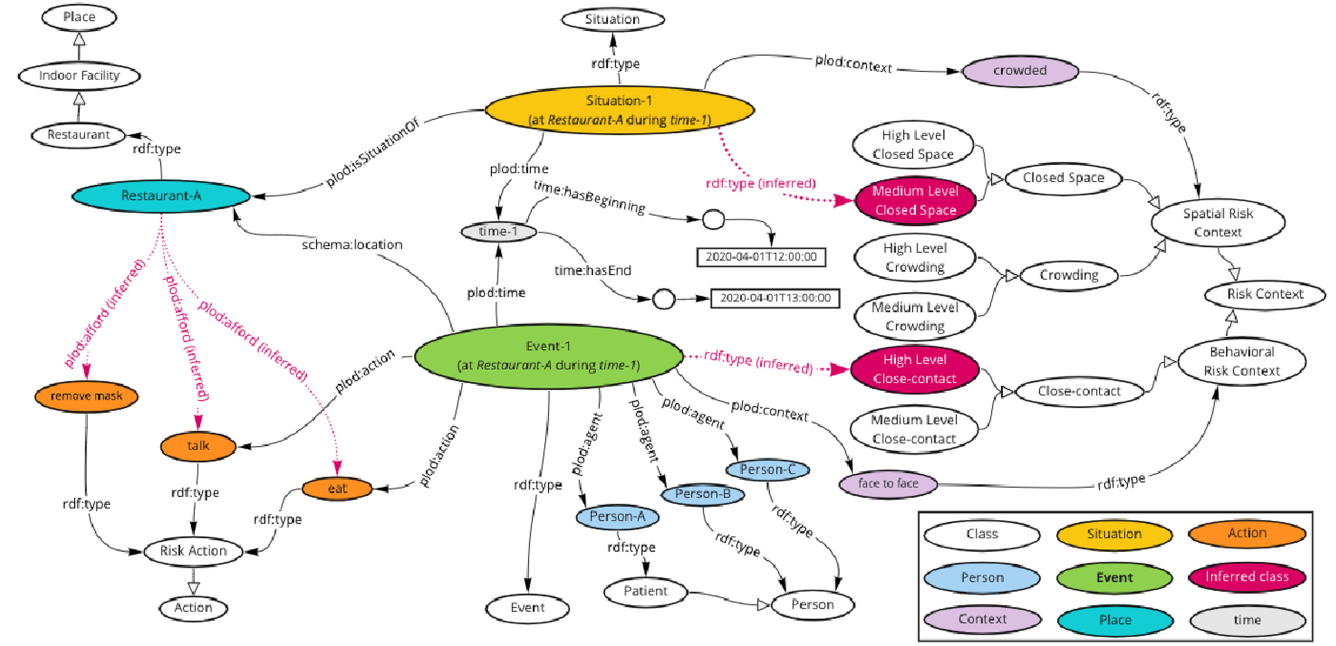
Fig 3. Example of a constructed knowledge